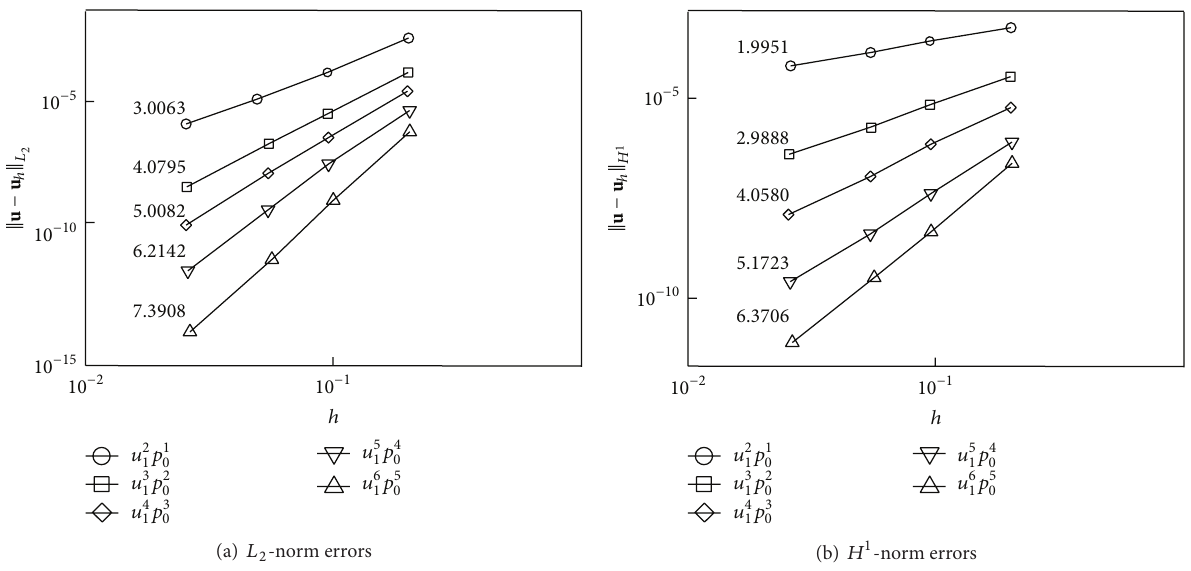
Figure 9: Velocity magnitude along vertical centerline.